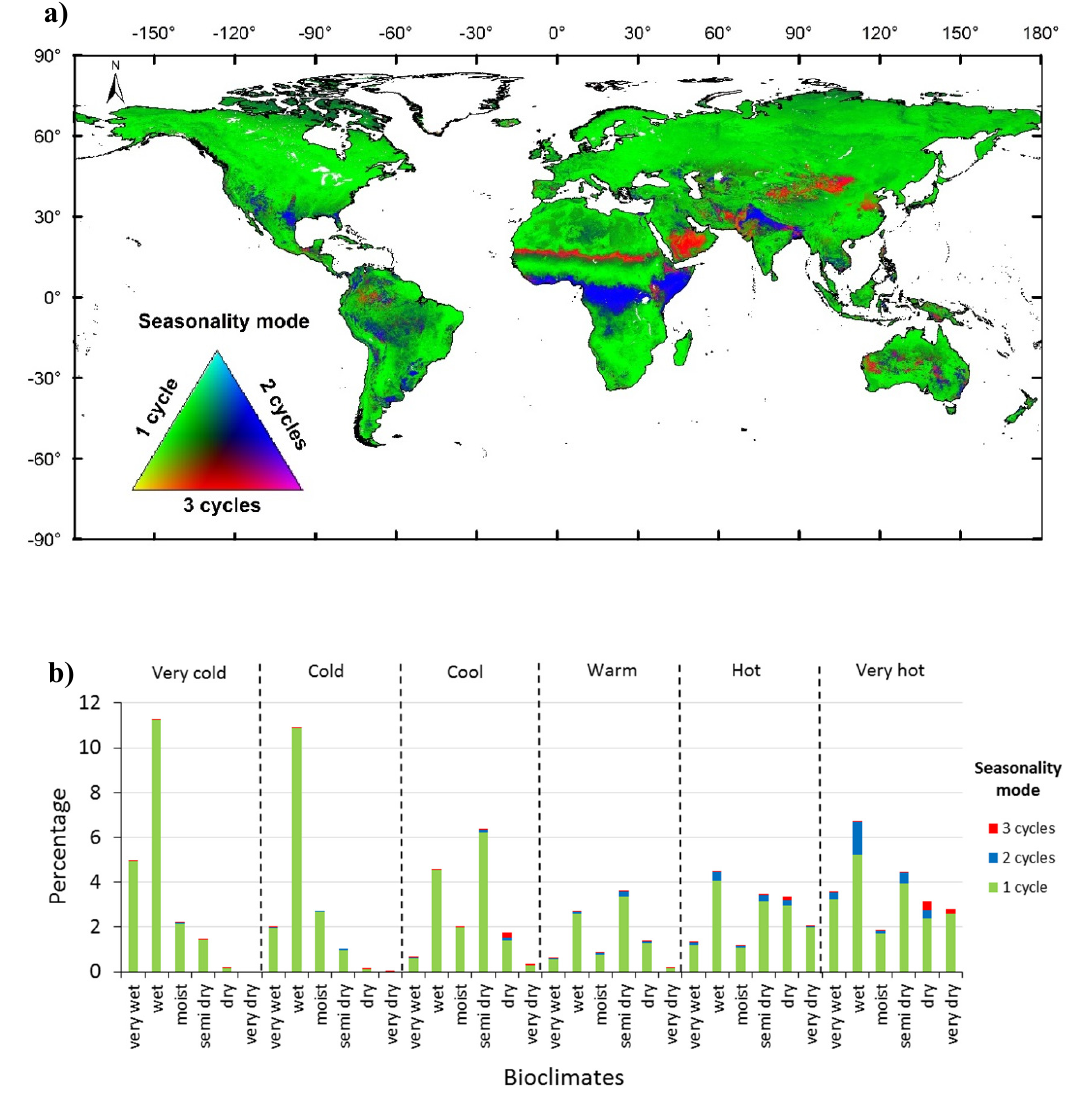
Figure 2. ( a ) Spatial distribution of the three seasonality modes in an RGB color composition. ( b ) Proportion of each type seasonality mode within bioclimates. Green, blue and red colors represent ecosystems with one, two and three intra-annual cycles.